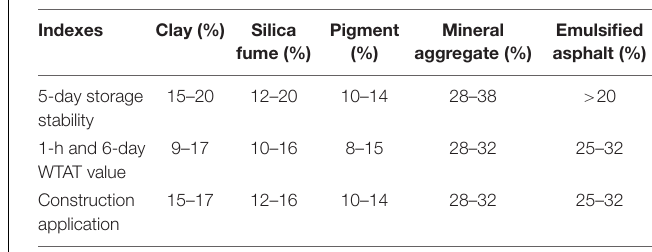
TABLE 7 | Application plan of